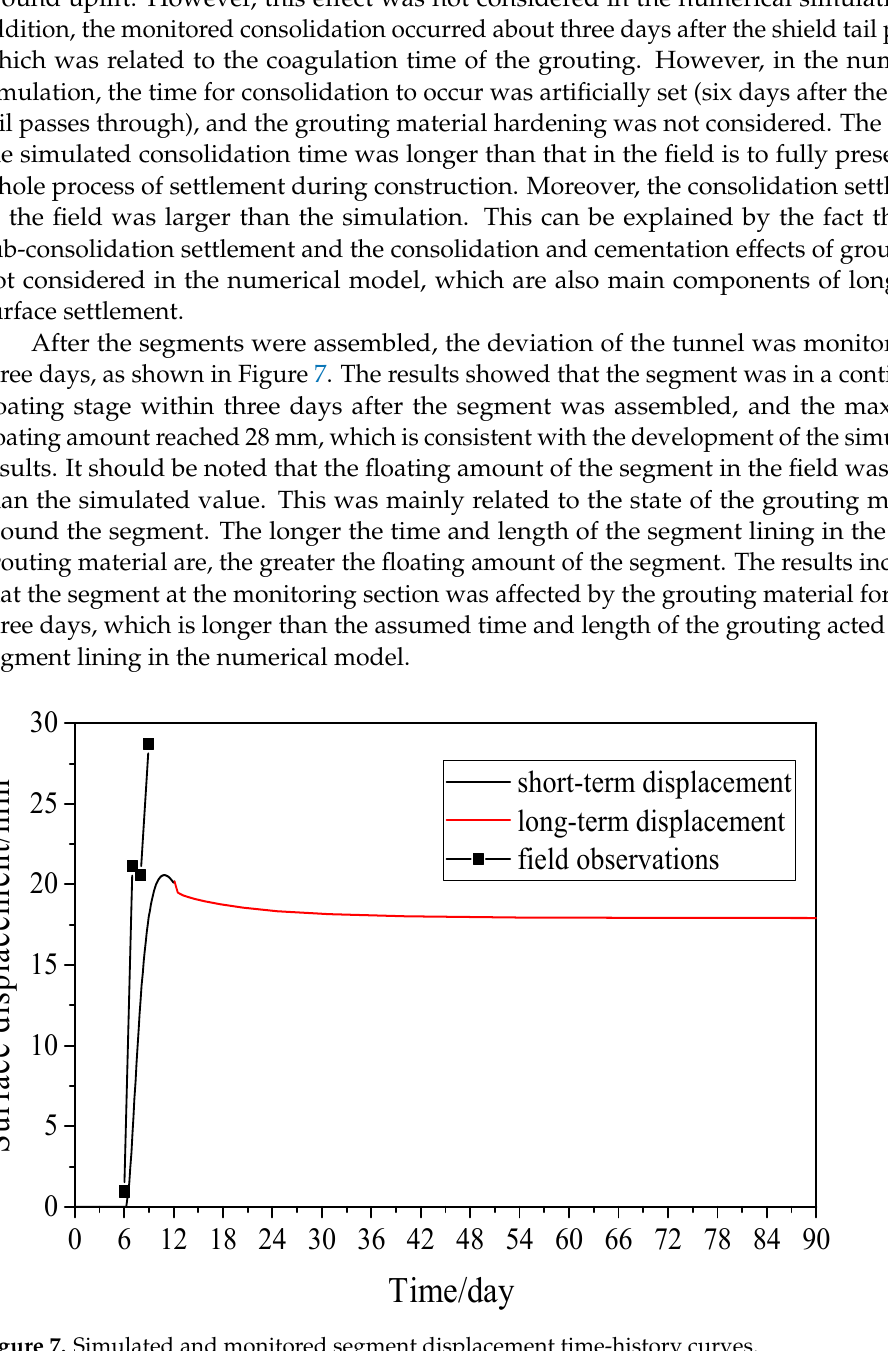
Horizontal distance from tunnel axis/m monitoring simulating Figure 8. Schematic diagram of shield tunnel excavation. 5. Sensitivity Analysis Shield construction in the soft soil layer will cause short ‐ term and long ‐ term settle ‐ ment of the ground surface and tunnel. For the long ‐ term settlement of surface and lining, it is difficult to analyze theoretically because it is affected by many factors, such as the thickness of soft soil under the tunnel and tunnel leakage. In addition, due to the high time cost of on ‐ site monitoring methods, the field study of long ‐ term settlement prediction is not suitable. In contrast, a sophisticated numerical model considering a variety of influ ‐ encing factors can simulate the long ‐ term settlement through fluid ‐ solid coupling, which can greatly reduce the time and cost of field monitoring. Based on the established model, this paper systematically analyzed the effects of grouting pressure, grouting filling rate, the thickness of soft soil under the tunnel, and